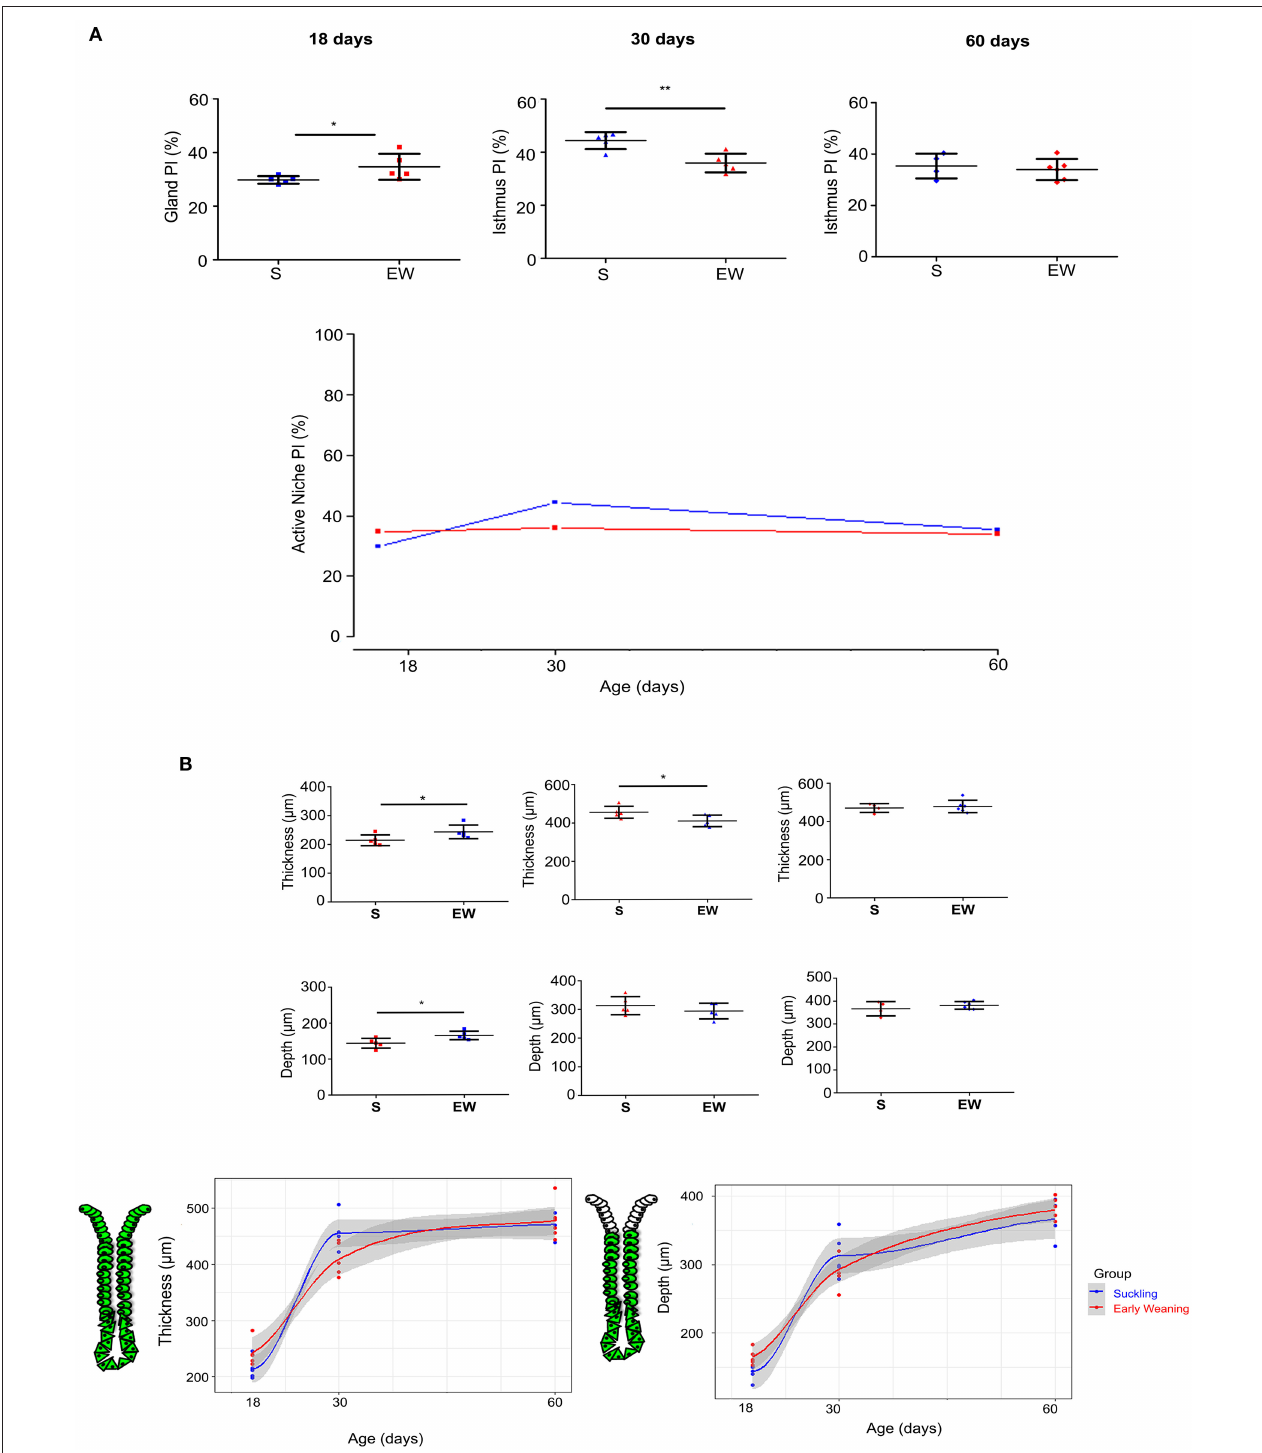
FIGURE 1 | Early weaning induces changes in cell proliferation in the gastric mucosa. (A) Proliferative index (PI) (%) after Ki- 67, counting at 18, 30, and 60 days. Results are represented individually: S (suckling, blue) and EW (early weaning, red) and by means ± SD. * p < 0.05 and ** p < 0.01 EW vs. the S group at the same age after Student’s t -test. (B) Left: The thickness of mucosa and gland depth were measured at 18, 30, and 60 days. The thickness was evaluated by measuring the distance from the base of the gland to the epithelial surface, and depth was obtained by measuring the distance from the base of the gland to the isthmus region. Results are represented individually for S (blue) and EW (red) and by means ± SD. After Student’s t- test: * p < 0.05, n = 10–15 fields/animal. Right: Growth curves were used to compare the growth of mucosa and gland depth between the S and EW groups at each age.